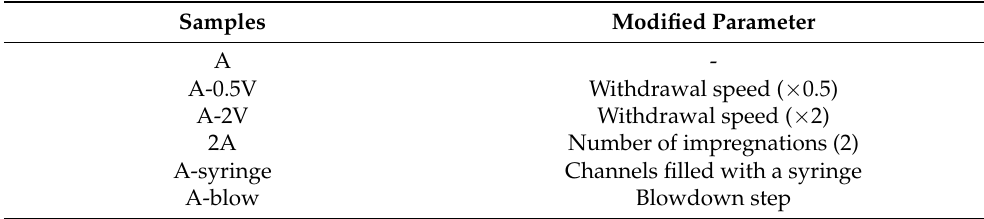
Table 2. Modifications of the coating procedures for sample